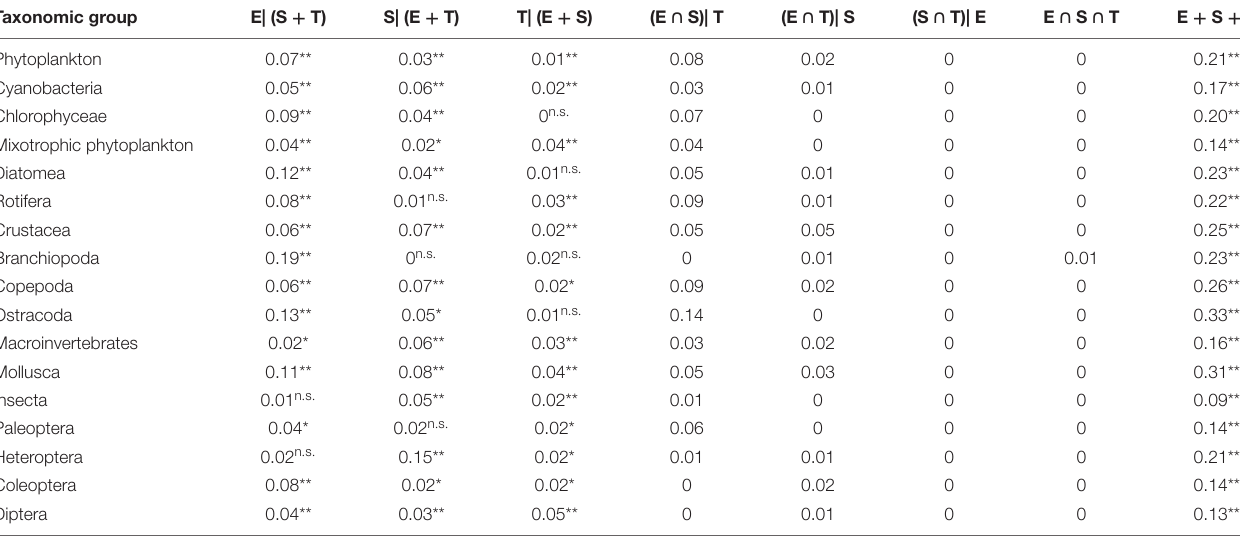
TABLE 1 | Results of variation partitioning analysis for each group, where E, environmental component; S, spatial component; T, temporal